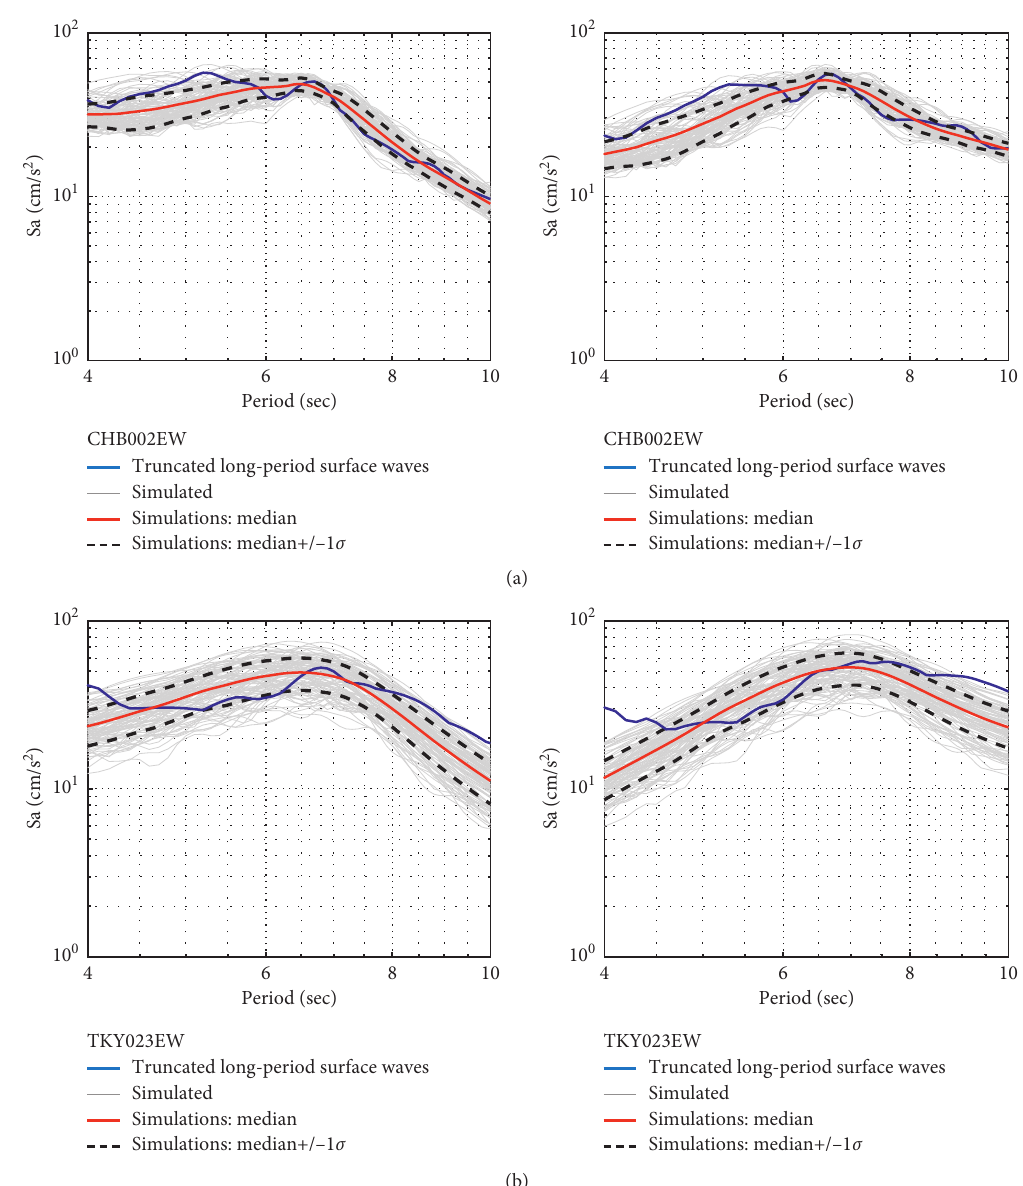
Figure 8: Response spectra for an ensemble of realizations of truncated long-period surface waves from two records of CHB002EW and TKY023EW (solid blue line). Of 100 simulated ground motions (thin gray lines), their median (thick red line) and median plus and minus one standard deviation ± σ (dashed lines) are involved; acceleration spectra on the left side; velocity spectra on the right side. (a) CHB002EW and (b)